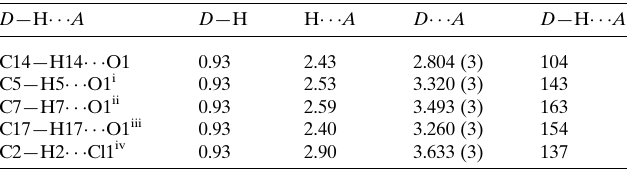
Table 1 Hydrogen-bond geometry (A˚ , (cid:2) ).